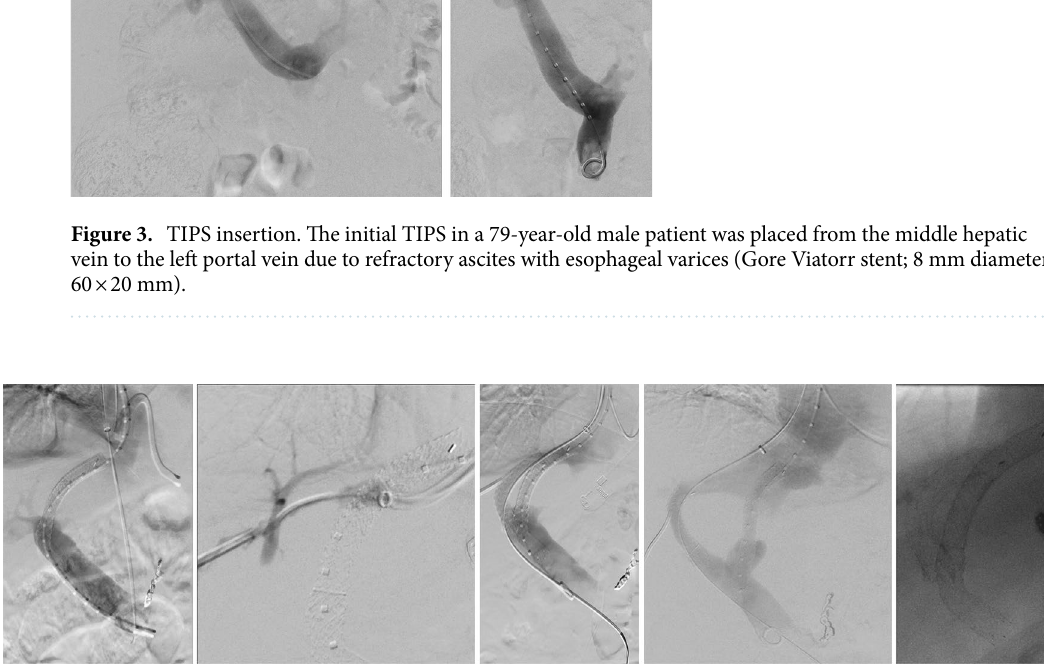
Figure 4. Second TIPS placement. A second TIPS implantation from the right hepatic vein to the right portal vein was necessary in the same patient due to persistent gastrointestinal hemorrhage. The initial TIPS remained